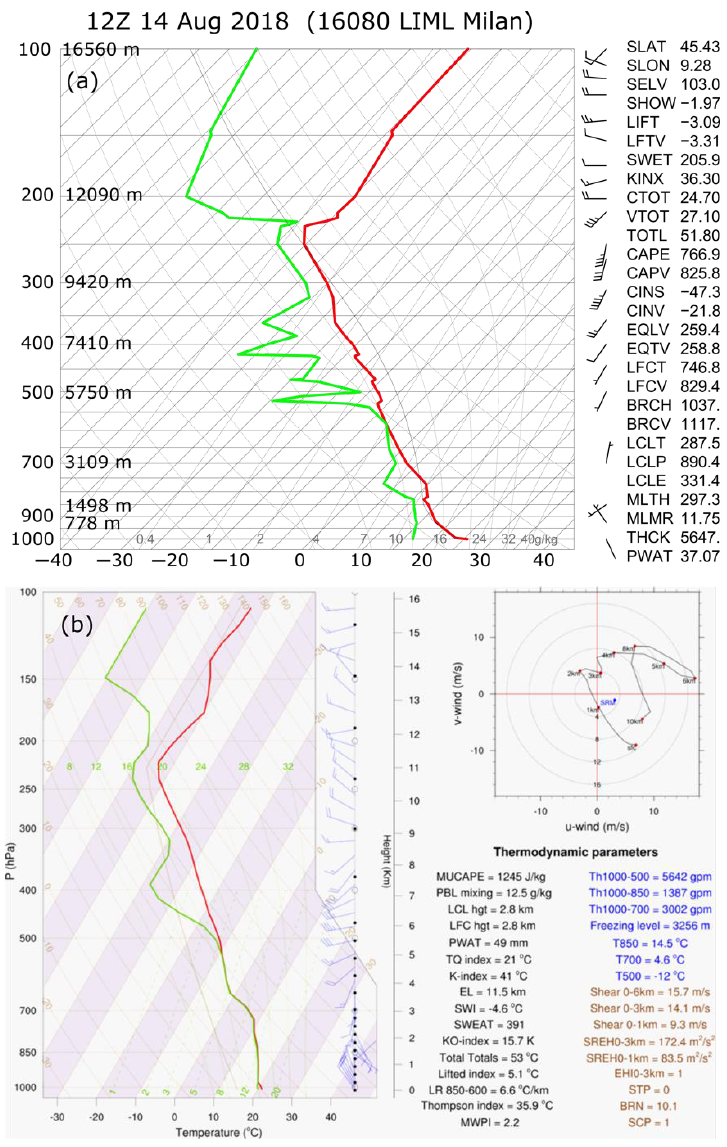
Figure 19. The WRF-IFS-DA thermodynamic diagram at 11:30 UTC in the middle of the convective structure shown in Figure 18i ( b ) compared with the radiosounding taken at Milan Linate at 12:00 UTC ( a ). IFS = Integrated Forecasting System; DA = data assimilation.